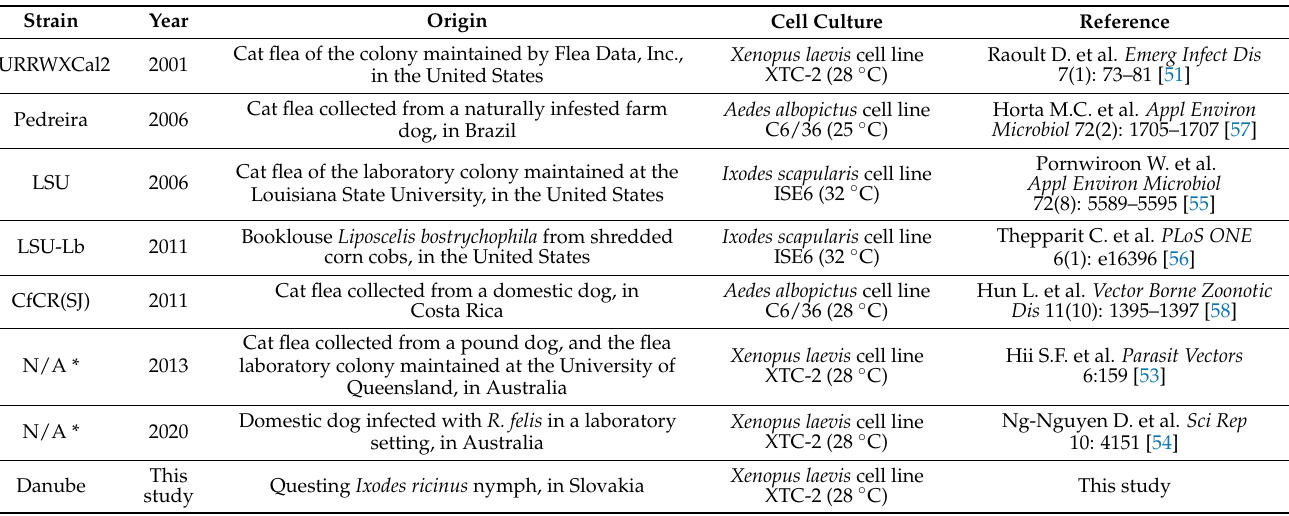
Table 1. Rickettsia felis culture-isolated